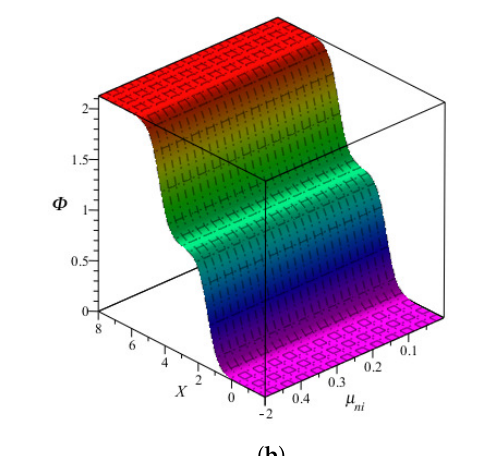
Figure 2. ( a ) Electrostatic single-shock wave excitation due to the variation of T with µ pi = 0.3 and effect of µ pi on the electrostatic ( b ) single-, ( c ) overtaking collision of triple-, and ( d ) overtaking collision of five-shock wave excitations with T = 5, respectively. The other parameters are chosen as α = 0.3, q = 0.35, M r = 3.75, T ni = 0.05, T e = 0.2, N r 1 = 0.5, N r 2 = 0.02, and µ ni = 0.01.